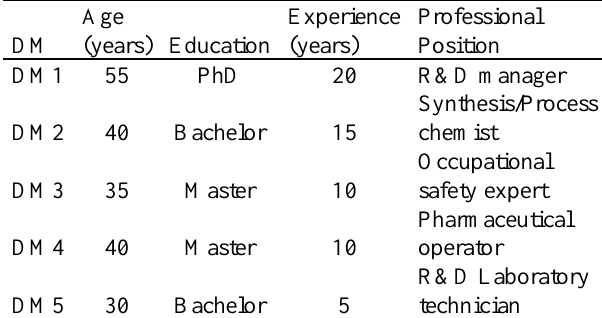
Table 3. The profile of